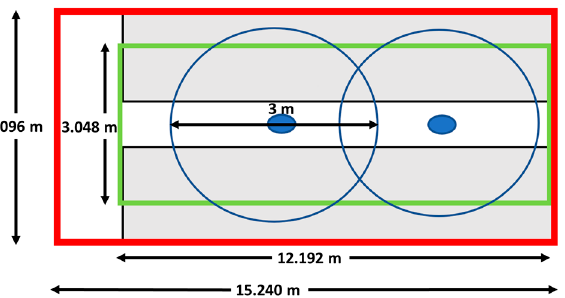
Figure 1. Garden dimensions: gardening area in gray; MDHS coverage green inner rectangle; and Polhemus sensor coverage two overlapping blue circles.